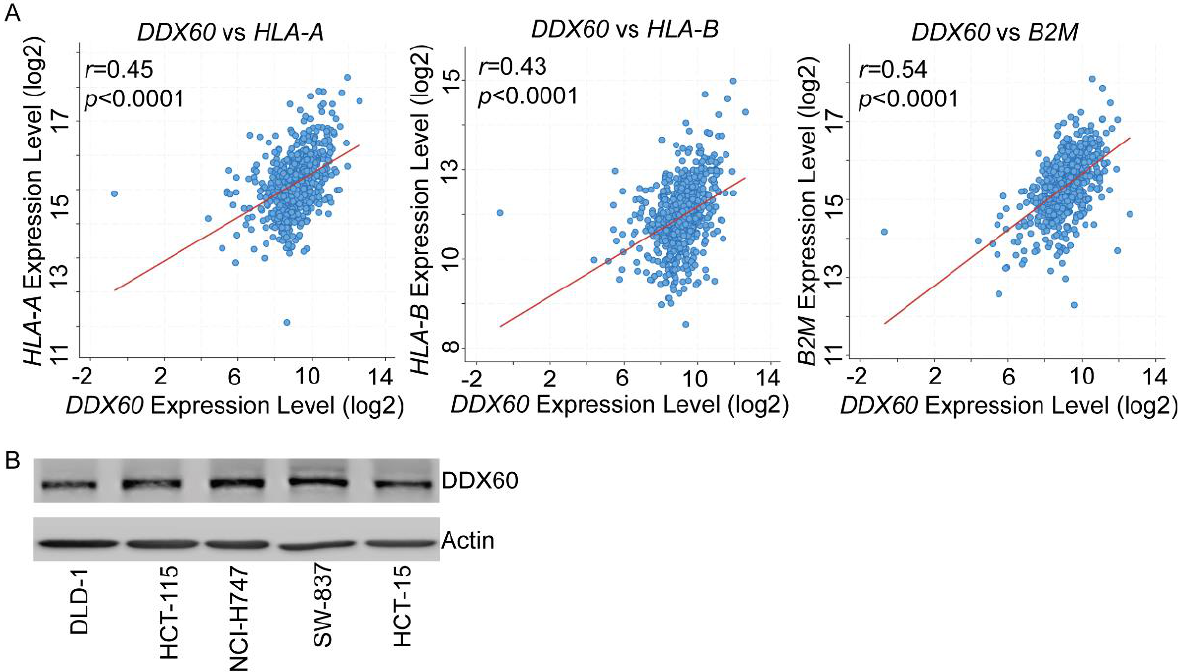
Figure 3. The expression of DDX60 is correlated with MHC-I expression in CRC. ( A ) Linear regression analysis showing the correlation between DDX60 expression levels (log2) and MHC-I-correlated molecules expression levels (log2) based on mRNA sequencing data of 459 TCGA CRC samples. ( B ) Western blotting images showed the protein levels of DDX60 and Actin in six different CRC cell lines .